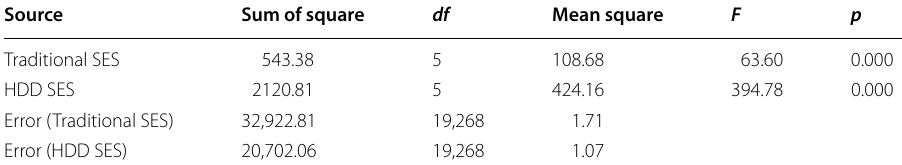
Table 7 Results of multivariate analysis of variance for comparing mean of six dataset Source